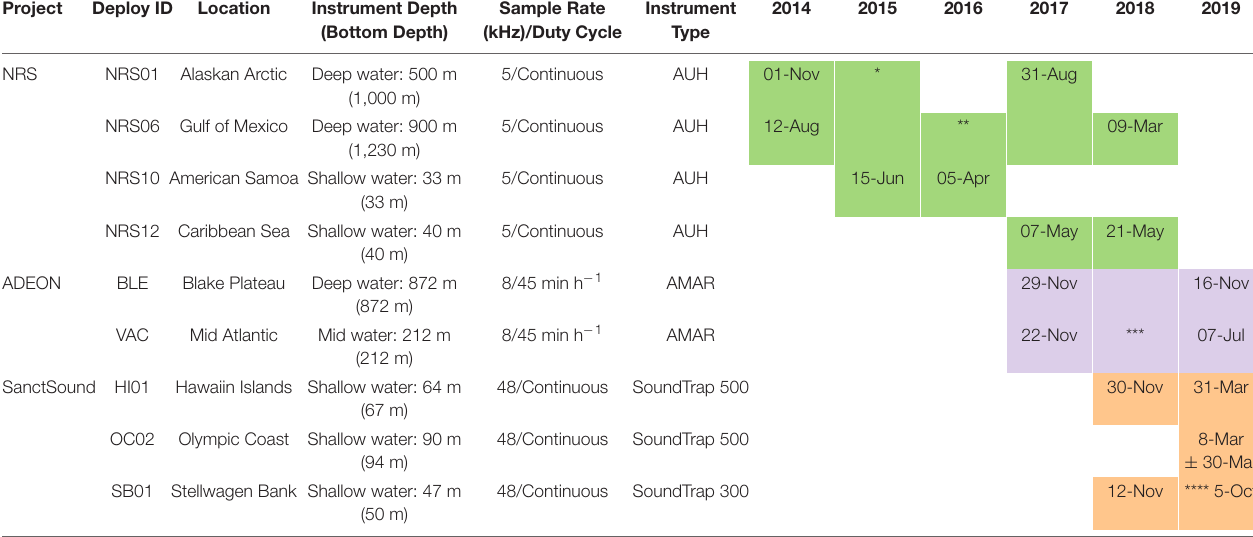
TABLE 1 | Archived deployments selected for analysis.